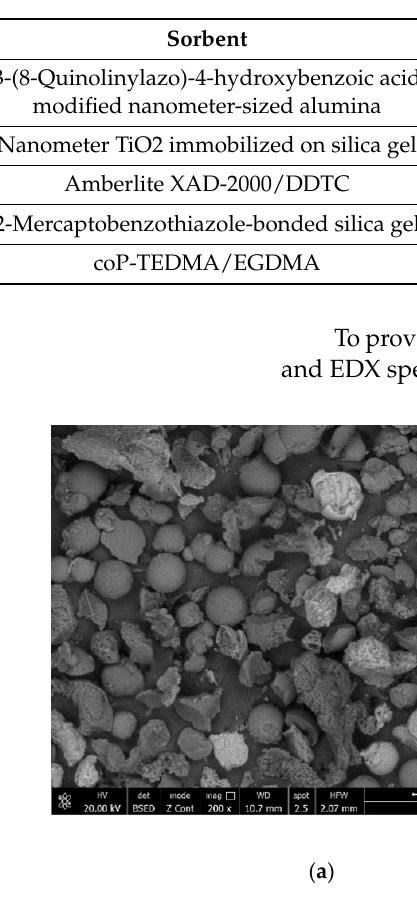
Figure 11. Scanning electron microscopy, SEM and energy dispersive X-ray, EDX, for exhausted coP-TEDMA/EGDMA after gold sorption. ( a ) SEM migrography; ( b ) EDX spectra.